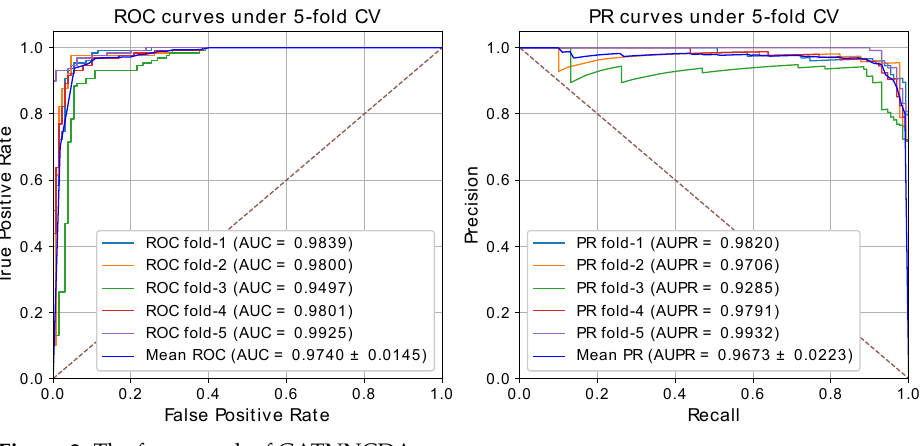
Figure 2. The framework of GATNNCDA. Table 1. Results of fivefold CV based on CircR2Disease dataset of best performance.